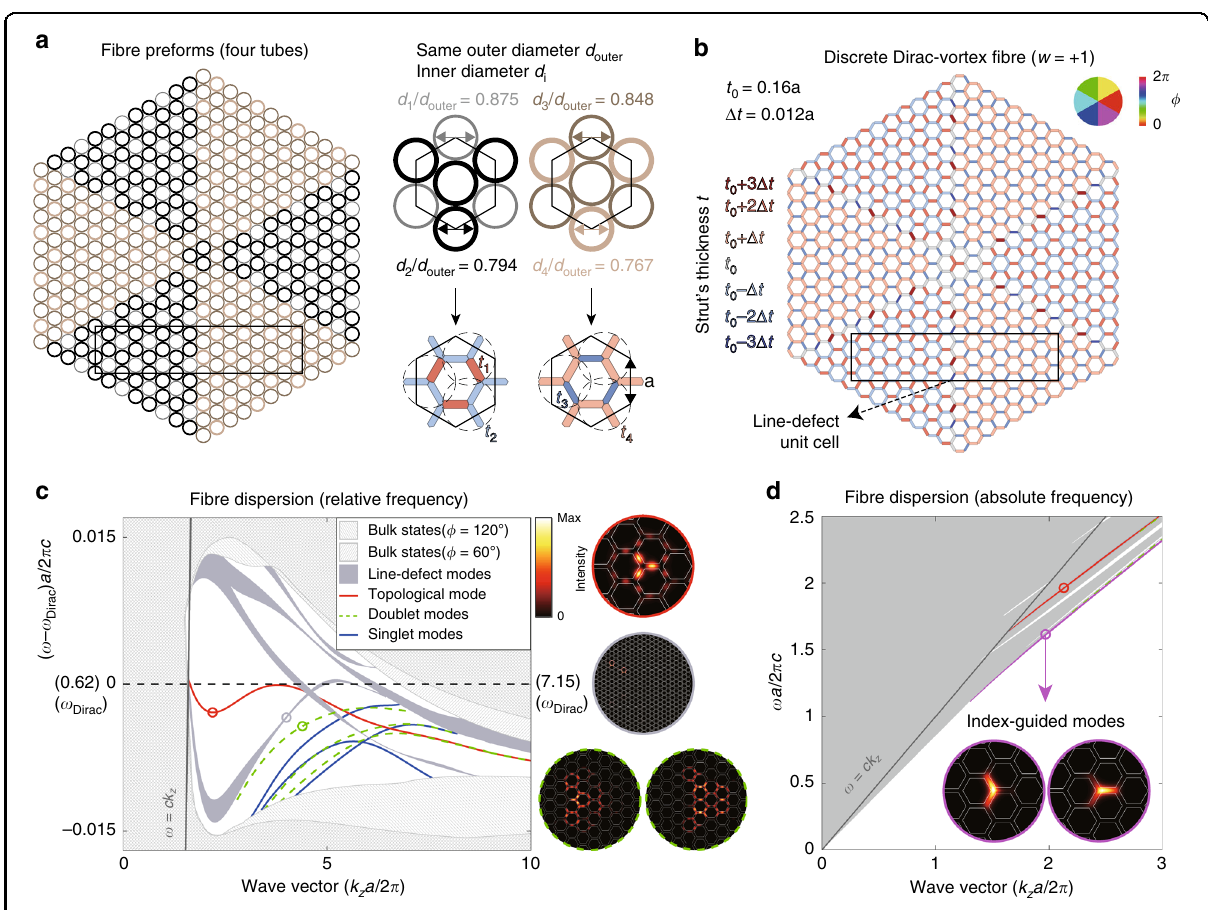
Fig. 5 Dirac-vortex fi bre obtained by discrete Kekulé modulations. a Fibre preform with four capillary silica tubes of the same outer diameter. b Fibre structure, having seven different strut widths, resulting from the preform in a . The black rectangle is the unit cell for the line-defect modes. c Band diagram with the frequency referenced to the original nodal-line of the unmodulated lattice. The higher-order modes are plotted with blue and green lines according their degeneracy. Insets show the mode pro fi les ( b z (cid:2) Re ½ E (cid:3) ´ H (cid:4) ). d Purple dispersion and mode pro fi les of the polarisation- degenerate index-guided fundamental mode. Other index-guide modes are plotted with green